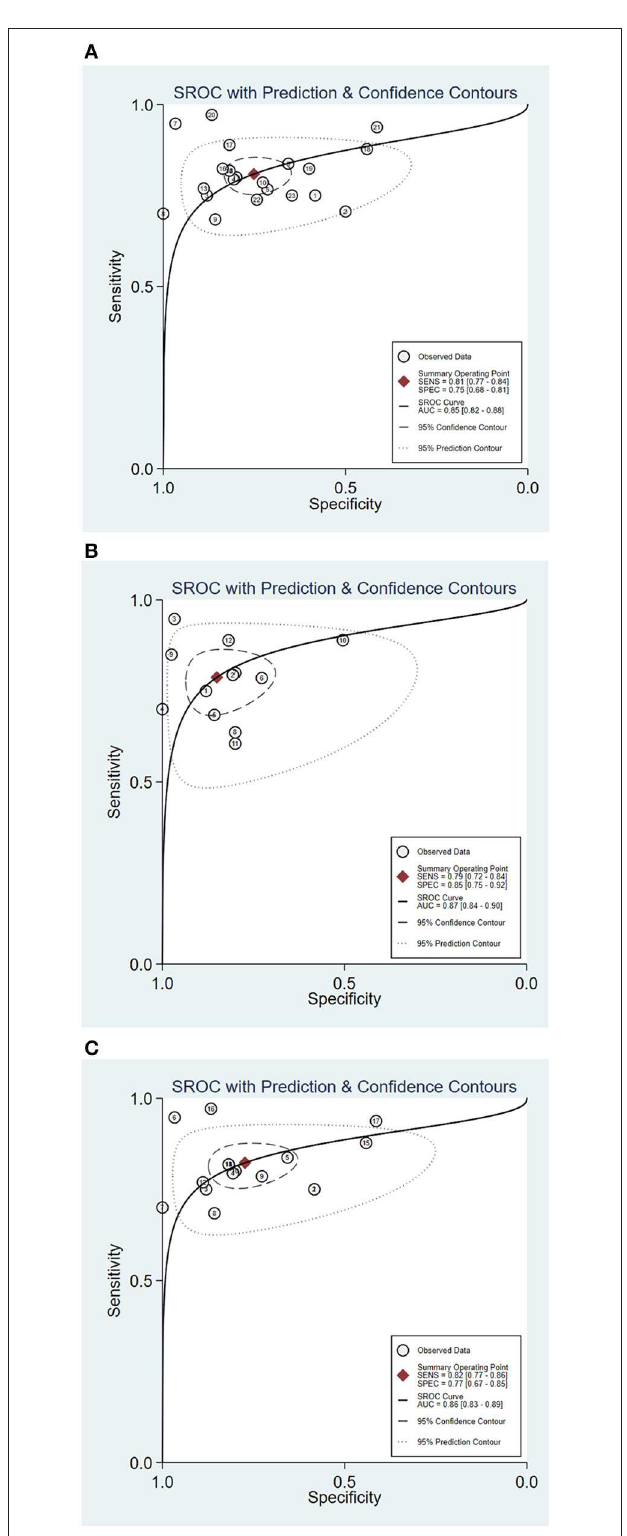
FIGURE 3 | Summary receiver operator characteristic (SROC) curve of circulating miRNA assay for MS [ (A) SROC of overall studies; (B) SROC for RRMS patient; (C) SROC of serum miRNA-based studies].